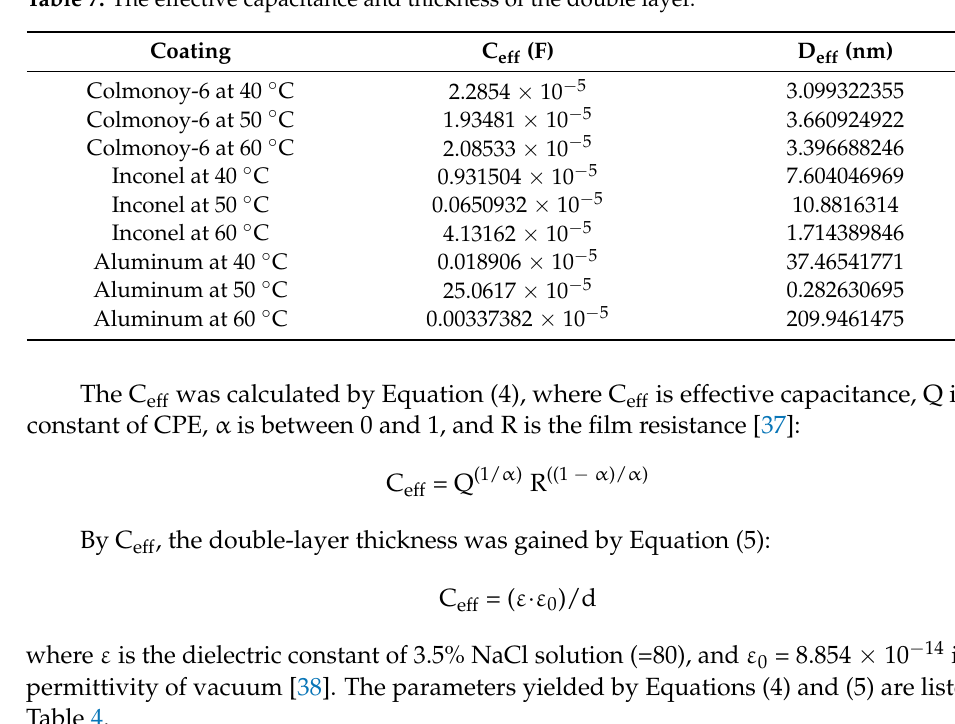
Figure 13. Equivalent circuits of ( a ) Colmonoy, ( b ) Inconel, and ( c ) Al coatings at 60 °C. Table 7. The effective capacitance and thickness of the double